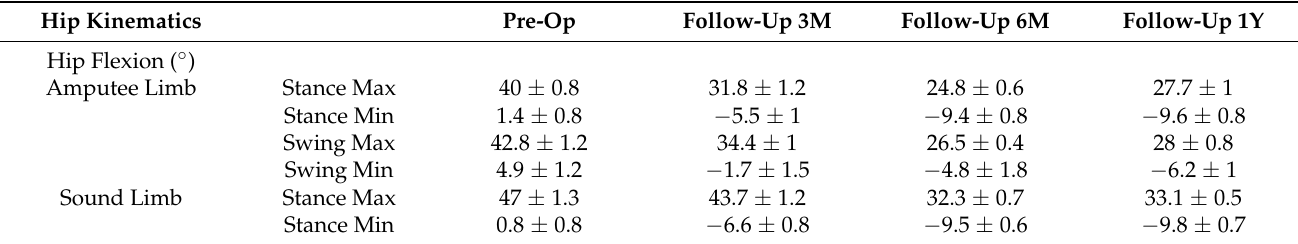
Table 4. Descriptive peak hip joint kinematics for the amputee and sound limb in the pre-operative gait analysis (socket-type prosthesis, ST) and the follow-up gait analyses (osseointegrated prosthesis, OI). Data are presented for the fast gait as mean ± standard deviation separately for stance and swing